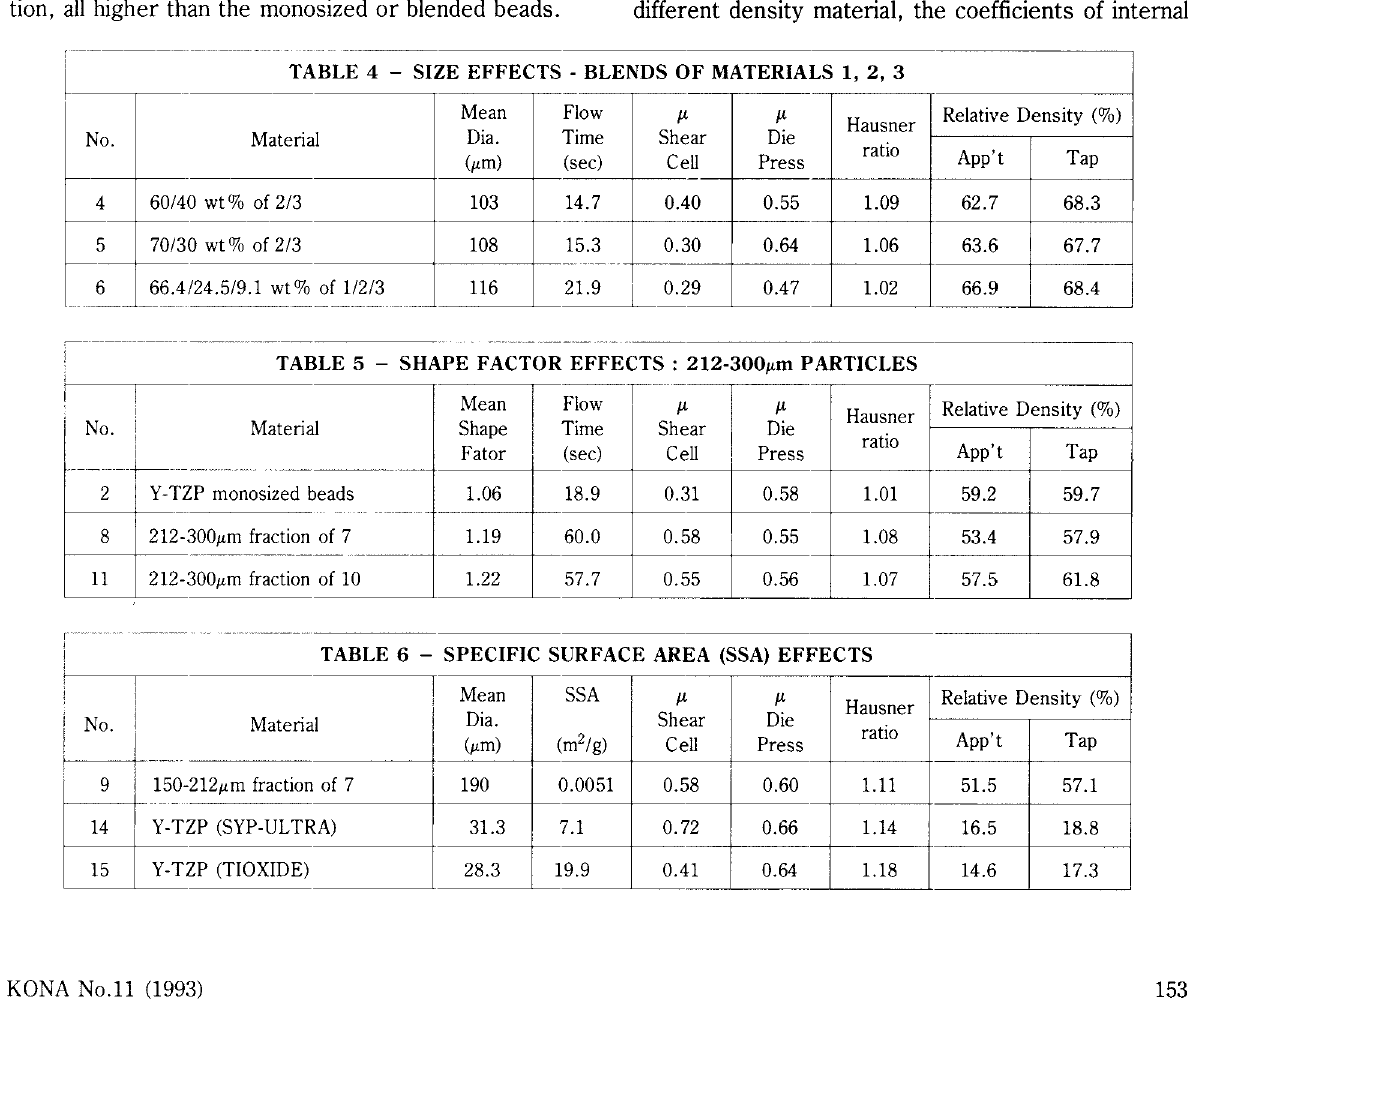
TABLE 5 - SHAPE FACTOR EFFECTS: 212-300/Lm PARTICLES